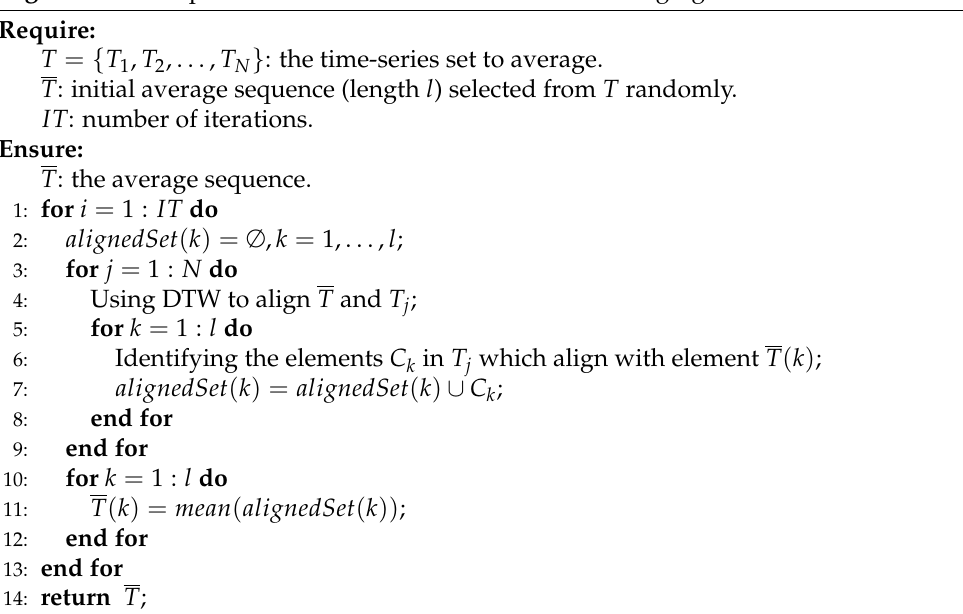
Algorithm 2 The pseudo-code of the DBA method for averaging time-series